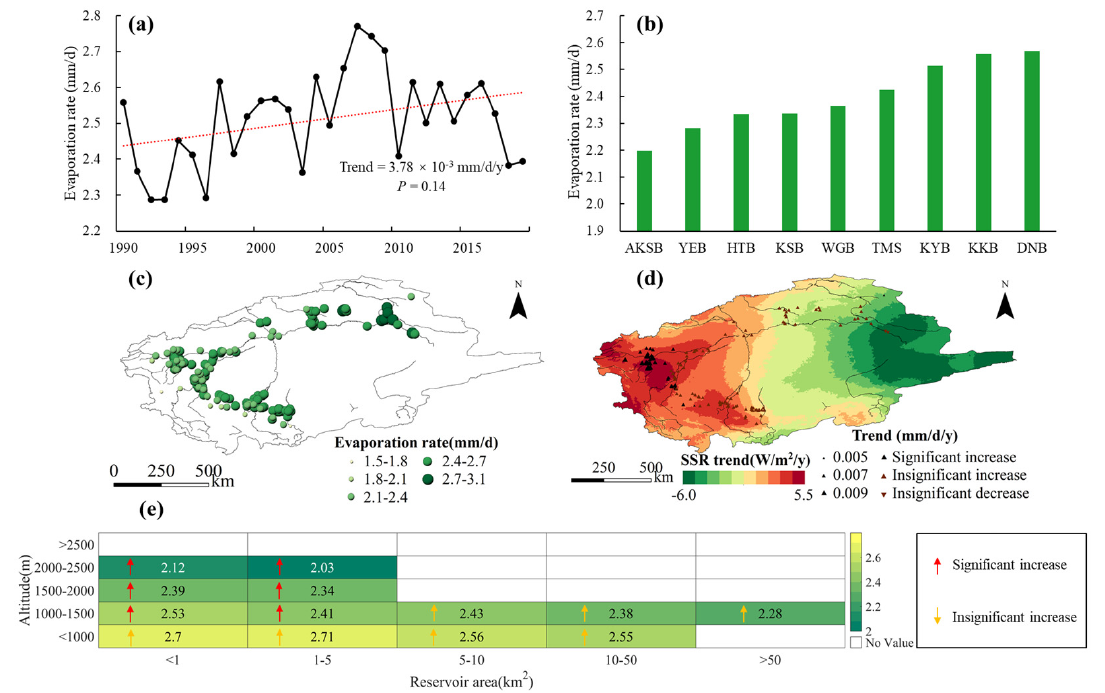
Figure 5. Evaporation rate of reservoirs in TB from 1990 to 2019: ( a ) Interannual variation trend of evaporation rate; ( b ) multi–year evaporation rates of reservoirs in each sub–basin; ( c ) evaporation rates of reservoirs; ( d ) variation trend of evaporation rate; ( e ) distribution and trend of evaporation rate of reservoirs at different altitudes and areas.